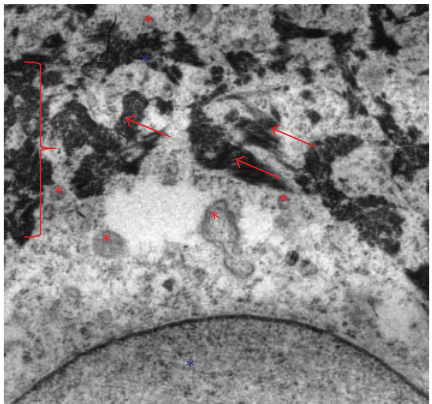
Figure 8: TEM images of AgNps (red arrows) in cytoplasmatic spaceoffibroblastpresentinahealedskinsampletreatedwithAgNP based Medical devices. AgNps are closed to the outer membrane of the mitochondria that are organized in the perinuclear zone of the cytoplasm (square barked red), recruiting the larger quantity of AgNps present in the